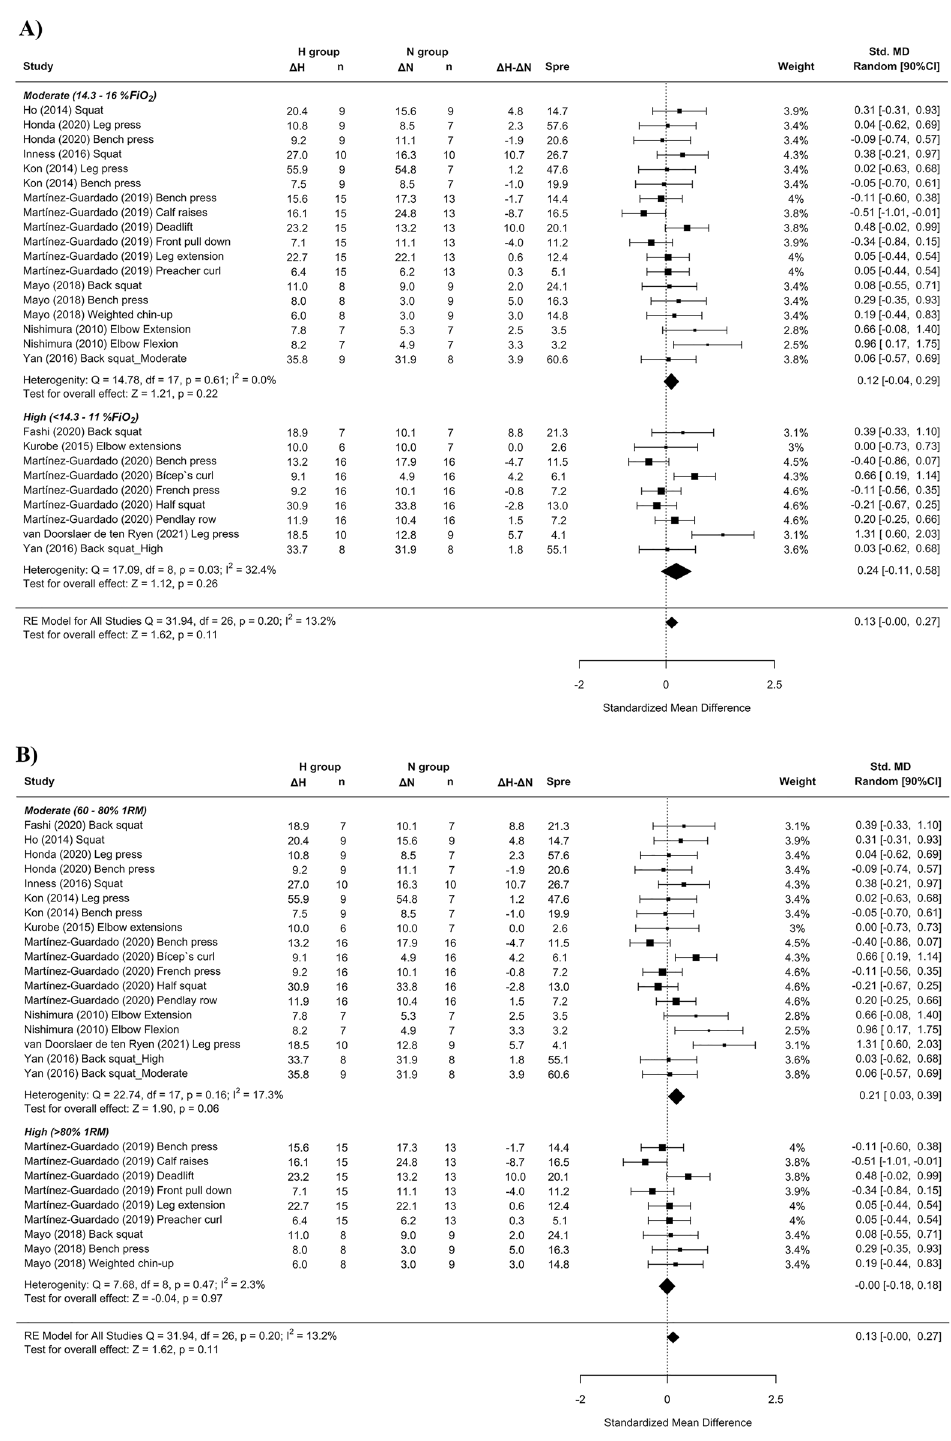
Figure 8. Forest plot of the standardized mean differences of the resistance training program between- conditions (hypoxic [H] group vs. normoxic [N] group) on RM, subanalysed by: ( A ) severity of the hypoxia; ( B ) training load; and ( C ) interset rest interval. Δ: mean differences between post–pre in H and N or between H-N; n: sample size; Spre: mean baseline standard deviation; Std. MD: standard mean difference; RE: random effect’s model; CI; confidence interval; FiO 2 : fraction of inspired oxygen; 1RM; 1 repetition maximum; Q: test statistic for the test of heterogeneity; df: degrees of freedom; p : p value; I 2 : I 2 test; Z: z value. Yan et al. 44 study provides a group with moderate hypoxia and another with high